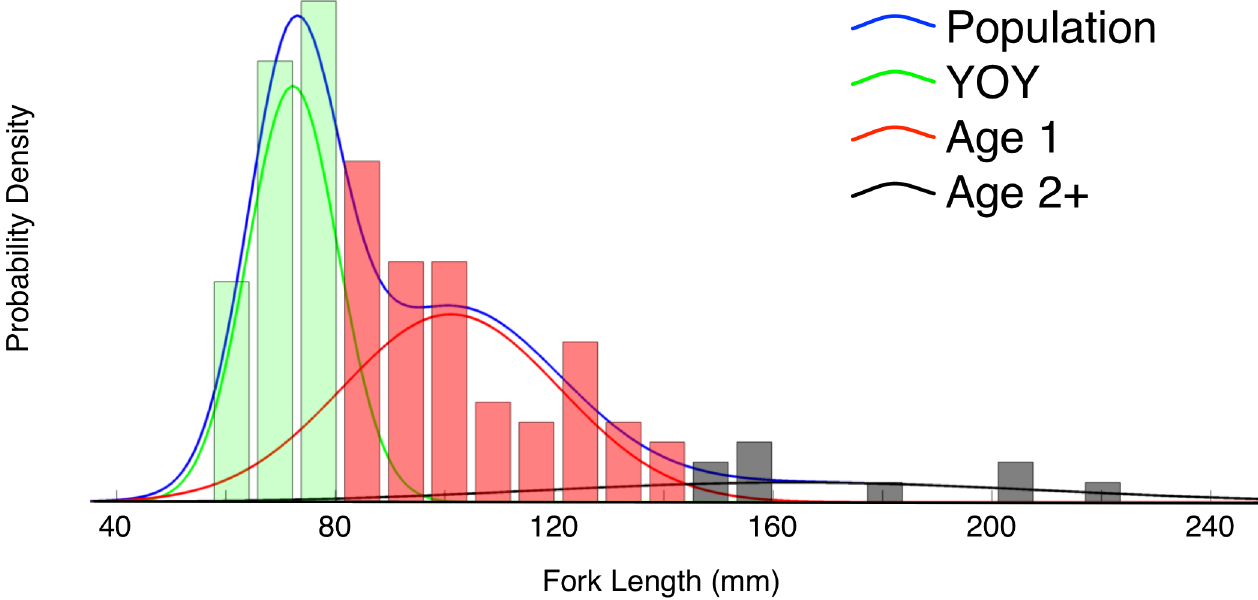
Fig 3. Example of the fitting procedure for estimating age and length distributions from October survey data. Blue curve is the probability density of the Gaussianmixture distributionrepresenting the entire sample (bars). Green, red and black curves are the individual components representing size distributions of YOY, age 1 and age 2+ fish, respectively.The shadingof the bars represents the componentto which each individual was assigned.